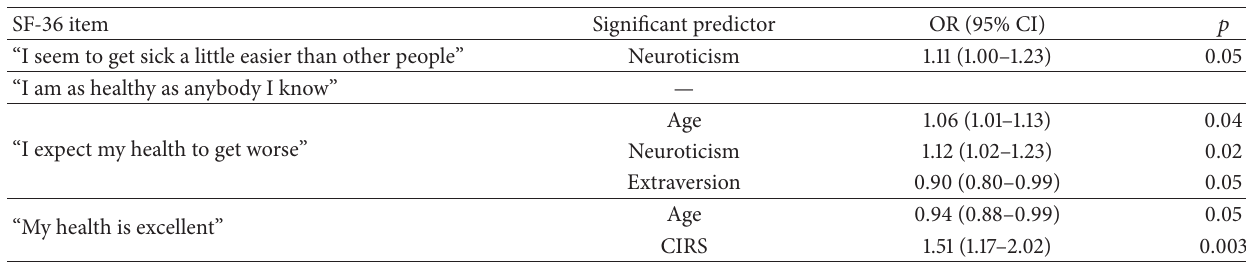
Table 3: Personality dimensions and covariates associated with poor perceived